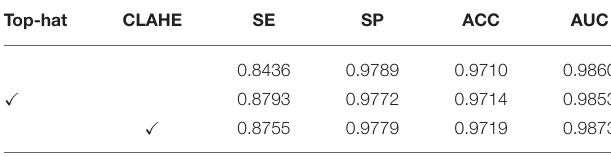
detect correctly vessel pixels and background pixels, respectively. TABLE 1 | Ablation study for pre-processing strategy on DCA1 dataset.